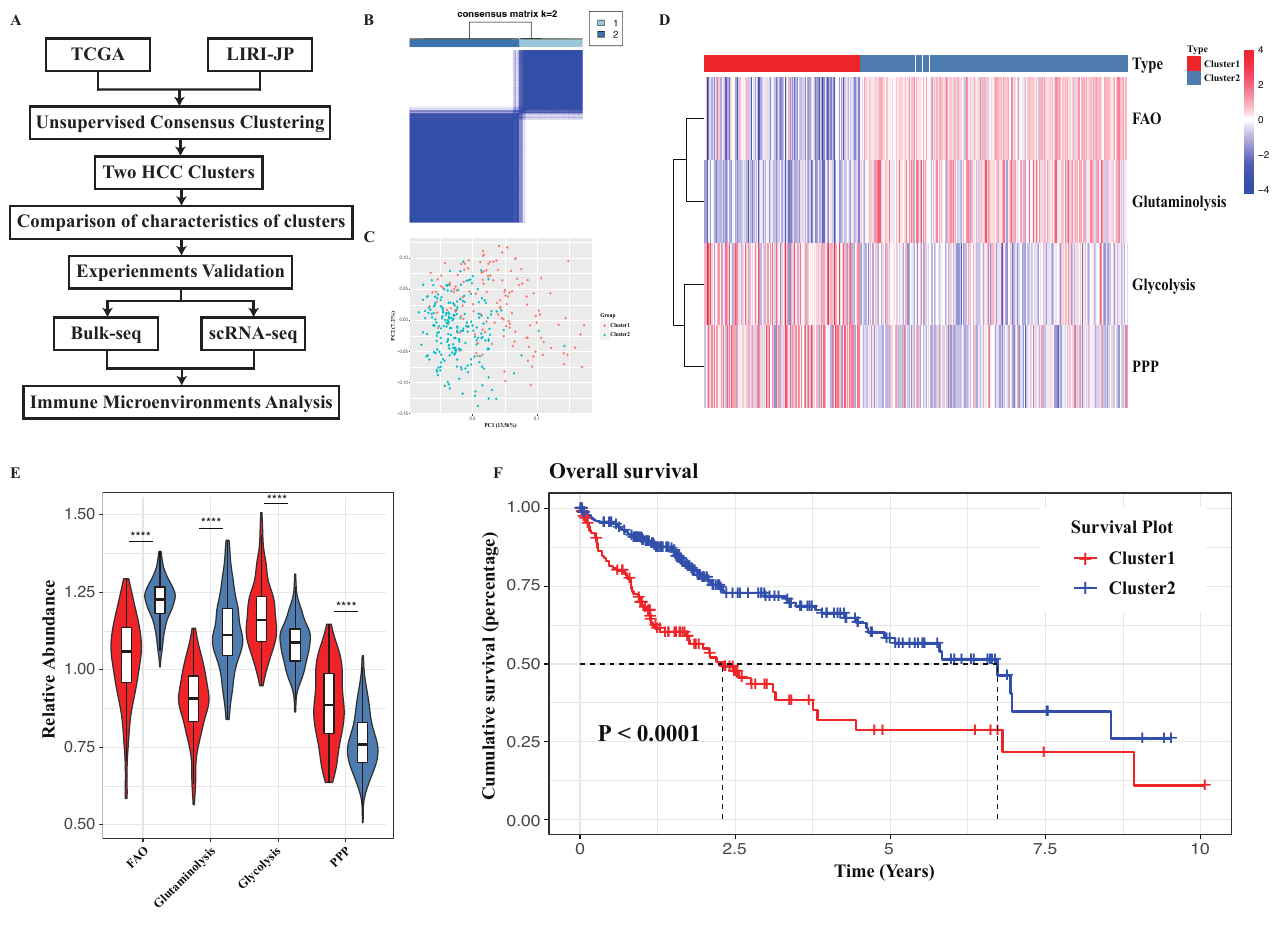
Figure 1. Metabolic heterogeneity of liver cancer is associated with prognosis. ( A ) Schematic diagram of this research. ( B ) A heatmap displaying consensus clustering of metabolic patterns using the k-means algorithm (k = 2). ( C ) Principal component analysis of two metabolic subgroups in the TCGA-LIHC datasets. ( D ) Heatmap displaying the activities of four energy metabolic pathways in liver cancers as calculated by the ssGSEA algorithm. ( E ) Relative energy metabolic pathway activity of two clusters. ( F ) Kaplan–Meier curves of OS between clusters in the TCGA-LIHC datasets. Log-rank test p values are shown. PPP, pentose phosphate pathway; FAO, fatty acid oxidation; ****, p value <